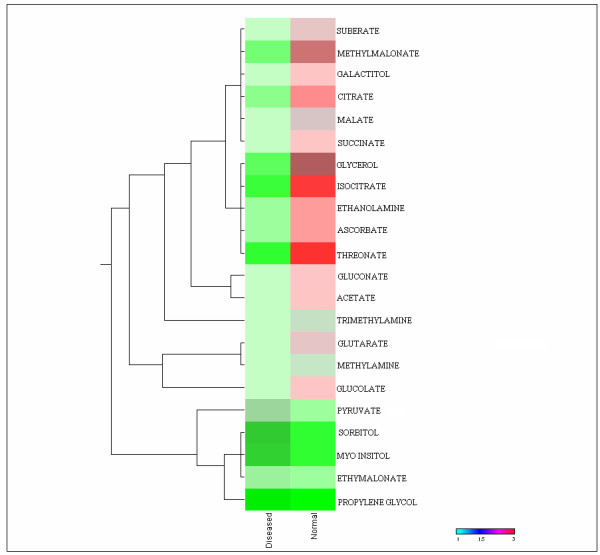
Heat map differentiation of metabolite. Average metabolite variability of blood plasma between PD patients (n = 43) and healthy controls (n = 37) are shown. Cluster analyses of the 22 differentially altered metabolites are selected based on significance P value (P < 0.05). The heat map depicts high (red) and low (green) relative levels of metabolite variation.